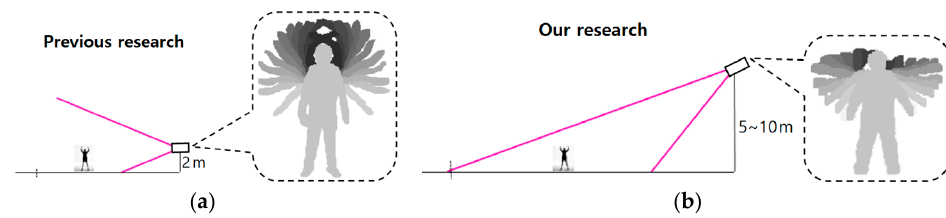
Figure 2. Comparison of different camera setup used in ( a ) previous research; ( b ) our research.